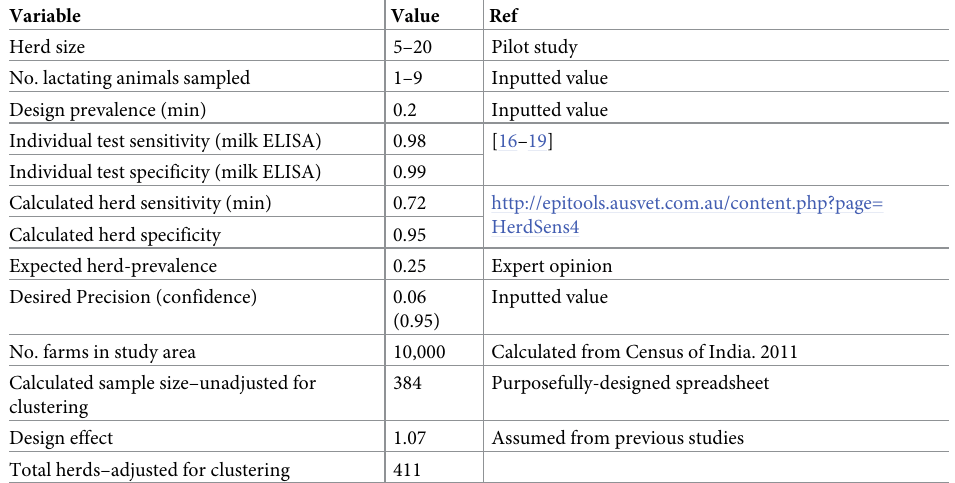
Table 1. Values used to calculate sample size in order to estimate farm-level